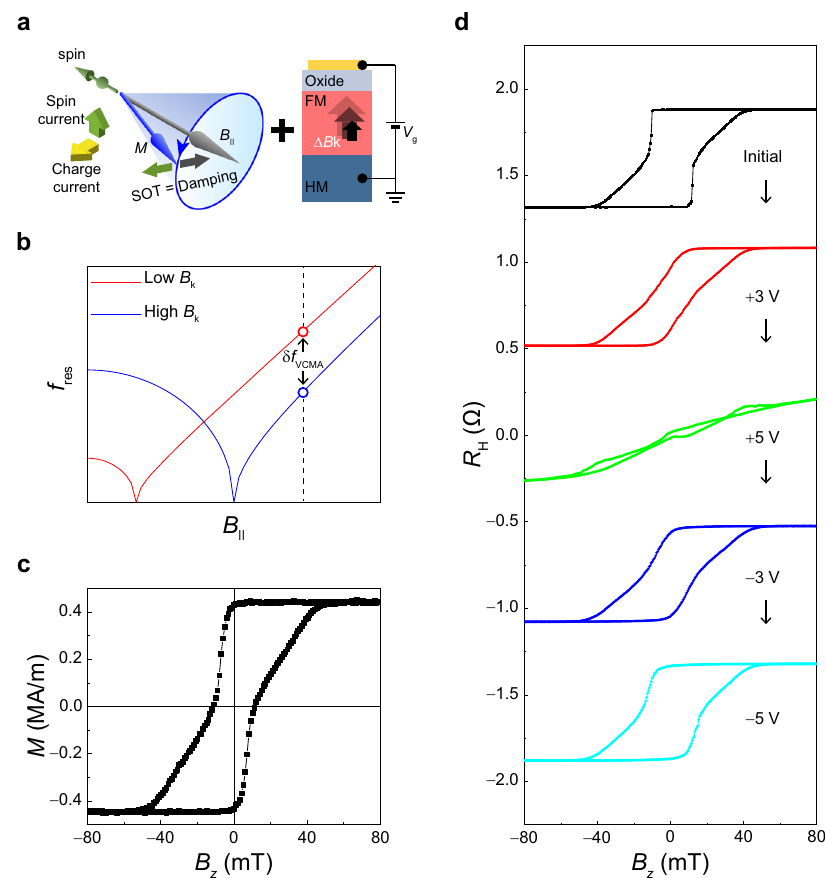
Fig. 1 Voltage-controlled perpendicular magnetic anisotropy. a Schematic illustration of the mechanism of the voltage-driven frequency tuning via voltage-controlled magnetic anisotropy (VCMA). The green and gray arrows represent the directions of spin-orbit torque and damping torque, respectively. b The resonance frequency ( f ) as a function of in-plane magnetic fi eld ( B jj ) for high PMA (blue) and low PMA (red). c Magnetization ( M ) res versus out-of-plane magnetic fi eld ( B z ) of the Co/Ni fi lm. d Anomalous Hall resistance ( R H ) curves of the Co/Ni sample for sequentially applied gate voltages of + 3 V, + 5 V, − 3 V, and − 5 V,